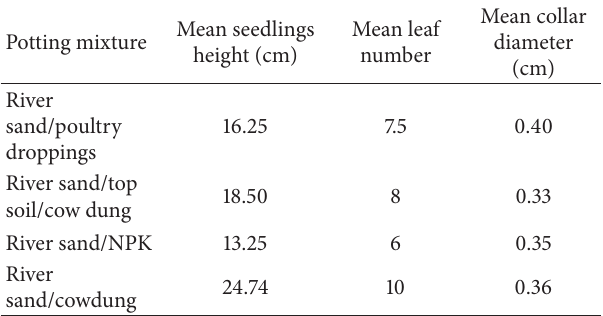
Table 1: Effects of pre-treatment on germination of T. indica seeds. Pre-treatment